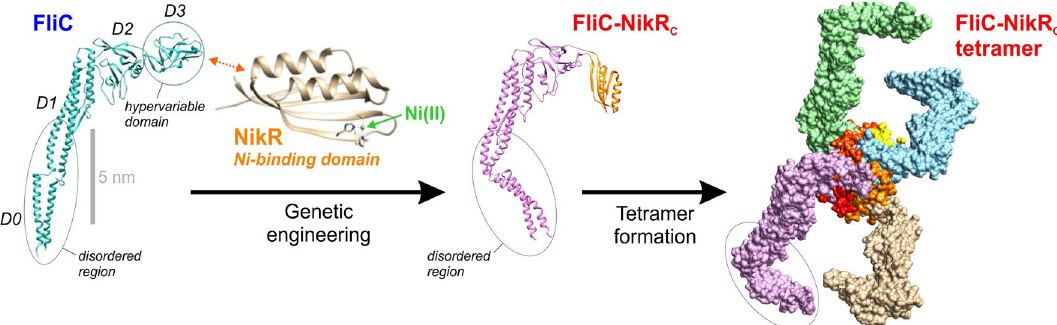
Figure 2. The 3D structure of the wild-type flagellin FliC, the genetically engineered FliC-NikR C and the FliC- NikR C tetramer that is spontaneously formed in solution. Each monomer unit of the FliC-NikR C tetramer has one HA Ni-binding site. Note that the D0 and partly the D1 domain forms a disordered region displaying high flexibility. While the structure of FliC (PDB ID: 1UCU) and NikR C-domain (PDB ID: 3BKU) is well established by electron microscopy, the shown structure of monomeric and tetrameric FliC-NikR C is based on modeling using the Chimera Software 65 . Due to the conformational variability in its disordered arms, only a hypothetical structure could be shown for the FliC-NikR C